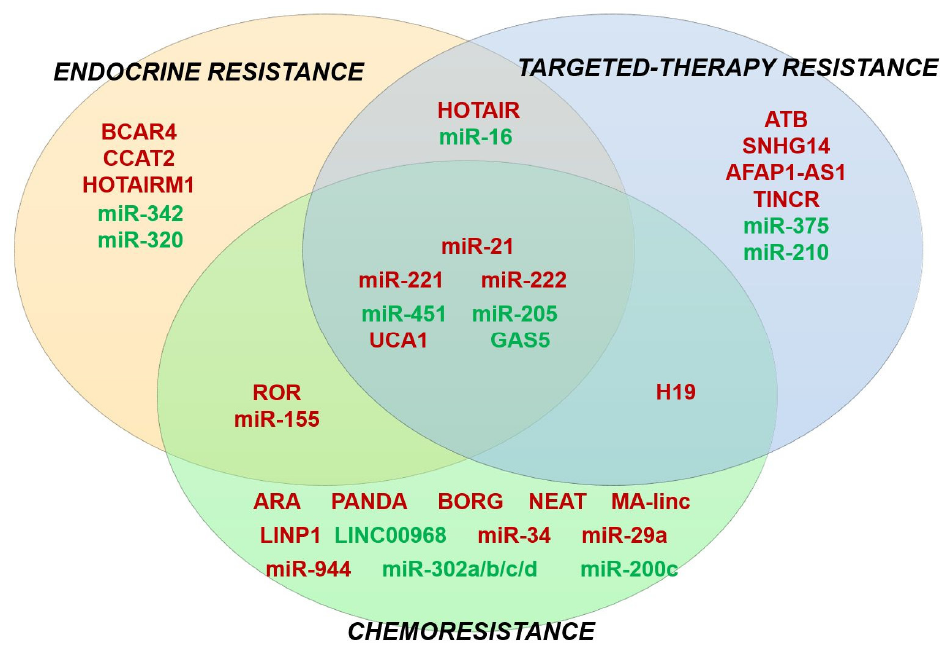
Figure 4. Venn diagram showing an overlapping role of several miRNAs and lncRNAs in multiple drug-resistant phenotypes in BC. ncRNAs with tumor suppressor functions are stained green, while oncogenic ncRNAs are stained red.